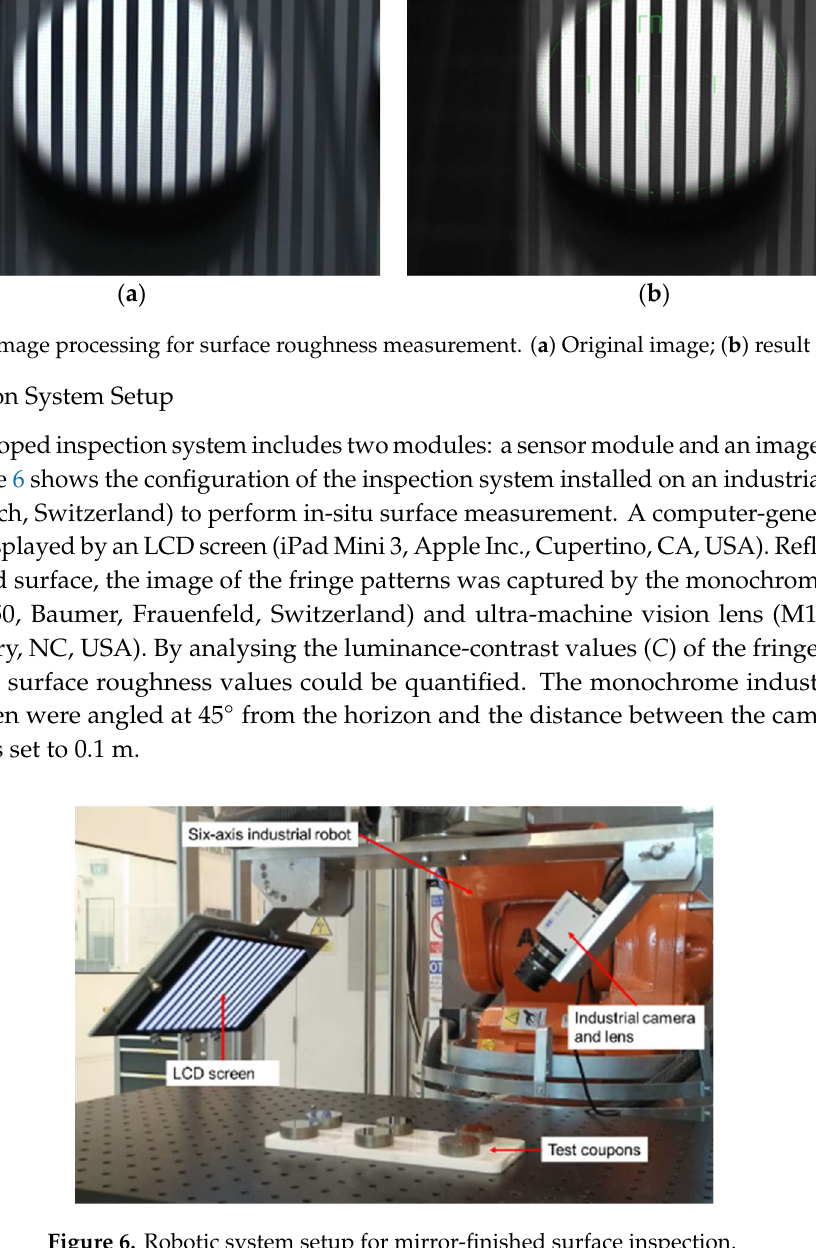
Figure 6. Robotic system setup for mirror-finished surface inspection.